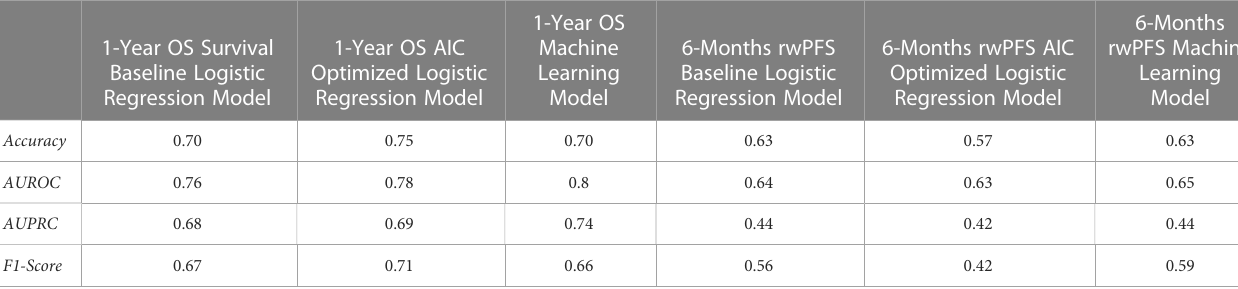
TABLE 2 Evaluation of model performance.